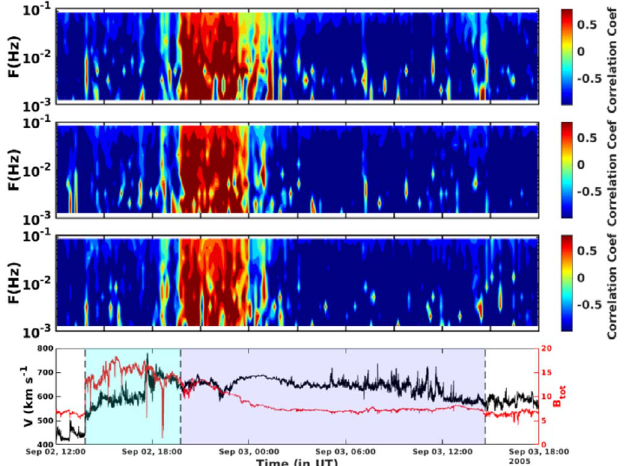
Figure 3. Analysis of the correlation between corresponding Δ V and Δ V A components. The red circles represent observations by the WIND spacecraft with a time cadence of 3 s. The coef fi cient of correlation is denoted by R . Each panel ’ s equation represents a linear relation fi tted between the respective components of Δ V and Δ V A .